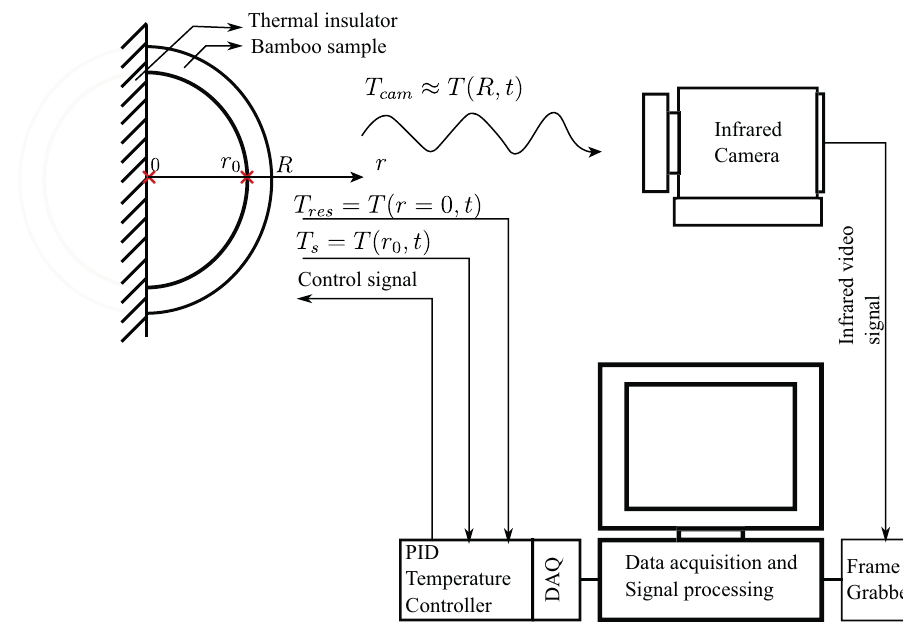
Figure 6. Scheme of temperature